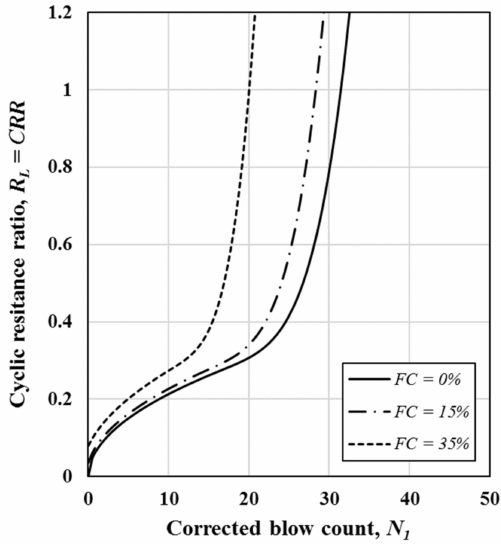
Figure 4. SPT-based resistance curve for different fine content values. The CPT-based simplified method proposed by Robertson (2009) is often used to evaluate soil liquefaction potential in engineering. The τ max in Equation (9) for calculating CSR are also estimated by ground motion analysis. Seed (1975) suggested that a factor of 0.65 peak cyclic stress ratio should be used to convert an irregular time series to equivalent uniform cycles N L , and an earthquake magnitude of 7.5 is equivalent to 15 cycles [37]. The CRR suggested by Robertson (2009) needs to classify the soil types into sand-like material ( I c ≤ 2.50), the transition region (2.50 < I c < 2.70) and clay-like material soil ( I c ≥ 2.70). Equation (13), where K c is the grain characteristics correction factor, Q tn is the normalized cone penetration resistance, F r is the friction